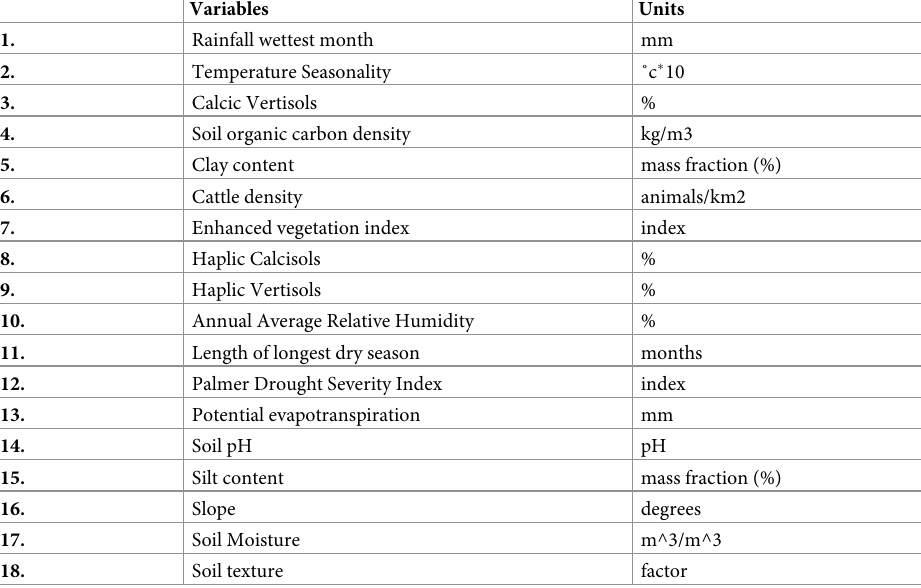
Table 1. Variables fitted in BRT algorithm for niche